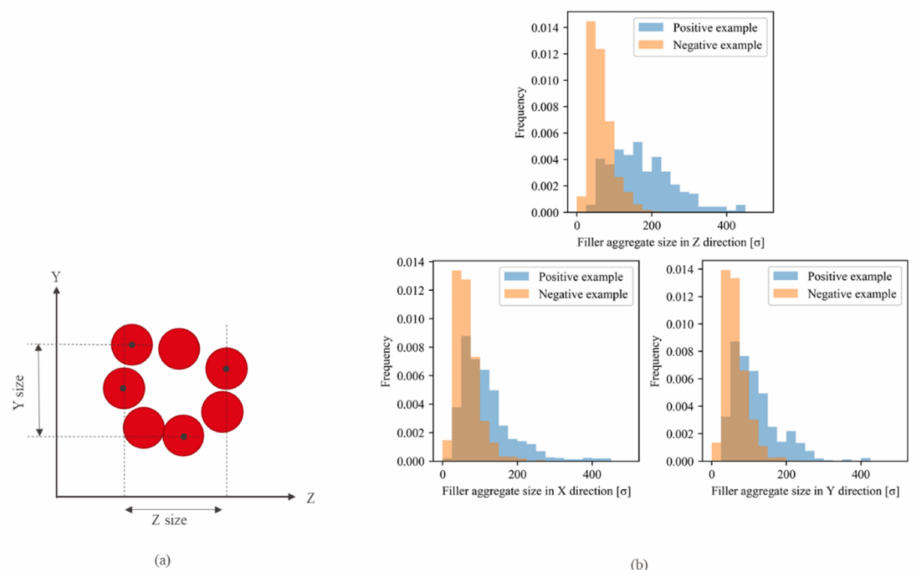
Figure 15. ( a ) Definition of the aggregate size. The red circles and black points represent the filler particles and their centers, respectively. The size in each direction is the difference between the largest and smallest coordinates along this direction. ( b ) Aggregate size distribution in each direction. The blue and orange bars denote the results obtained for the positive and the negative examples, respectively. Z-direction is the elongation direction of the system, while X- and Y-directions are compressed during